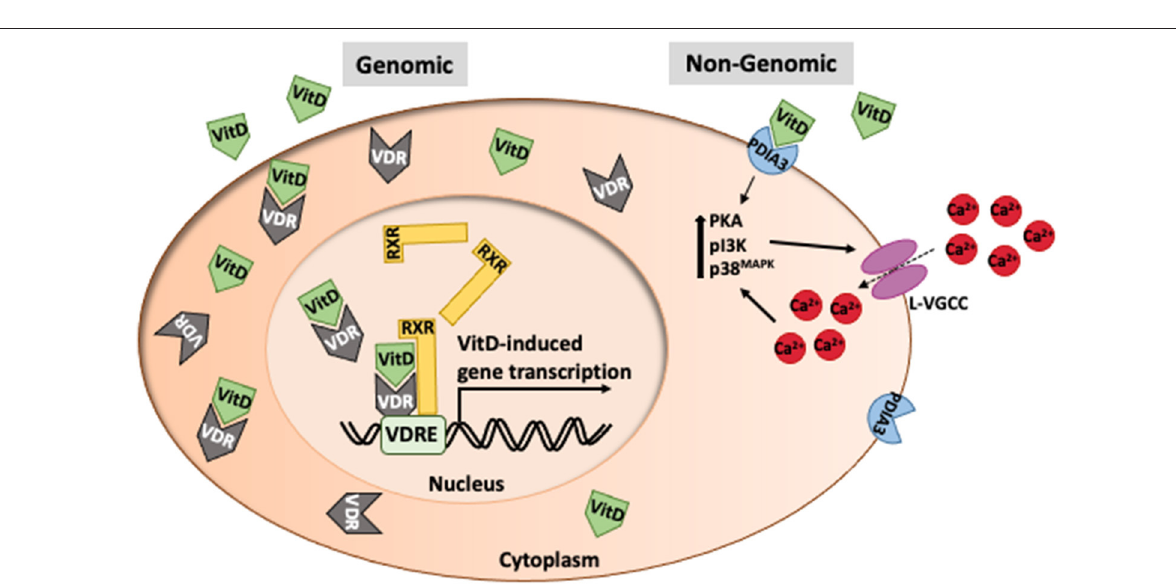
FIGURE 2 | Intracellular function of vitamin D. VitD typically acts as a transcription factor in association with retinoid-X-receptors (RXR) to mediate gene transcription at VitD response elements in promoter regions of genes. However, VitD can have immediate effects on cell function (non-genomic) via interaction with PDIA3 that leads to changes in calcium